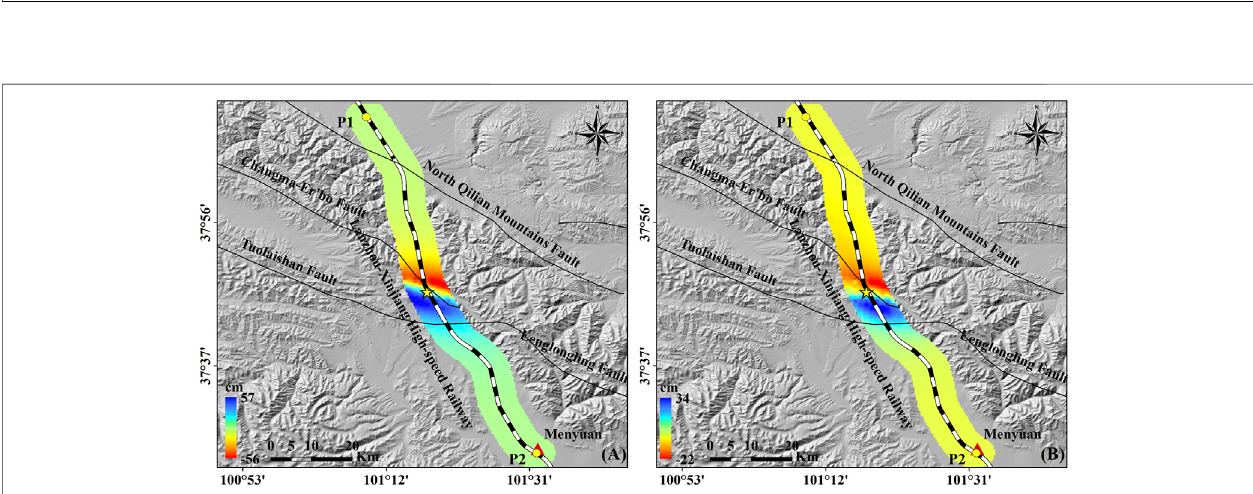
FIGURE 11 | LHSR section P1-P2 in (A) east-west and (B) up-down 5 km buffer zone deformation map.